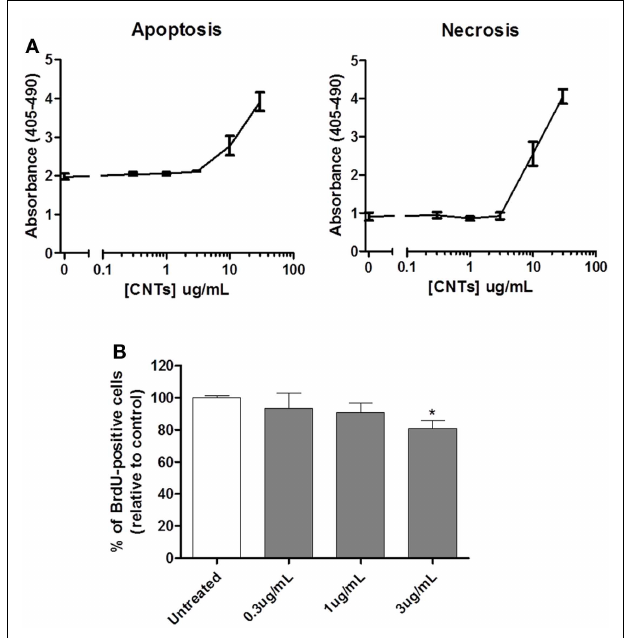
FIGURE 1 | Effects of CNTs on cytotoxicity and proliferation of glioblastoma cells . (A) U251 glioma cells were treated with different doses of CNTs and evaluated after 72h using the cell death ELISA. Doses of CNTs <3 µ g/mL were not cytotoxic; apoptosis (left panel; p < 0.05; n = 3) and necrosis (right panel; p < 0.05; n = 3). (B) U251 glioma cells treated with CNTs (0.3–3 µ g/mL) were evaluated for proliferation after 72h using Brdu incorporation assay; 3 µ g/mL significantly reduced cell proliferation ( n = 3, * p <